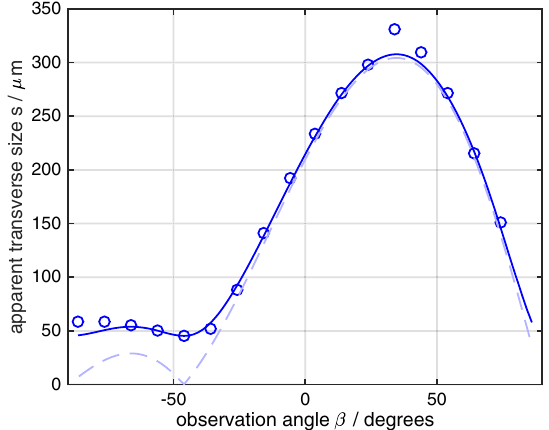
FIG. 4. Observed beam size, as a function of observation angle β . Circles: experimentally obtained data, dashed line: calculated values using Eq. (1), solid line: calculated values, with the initial beam size added in